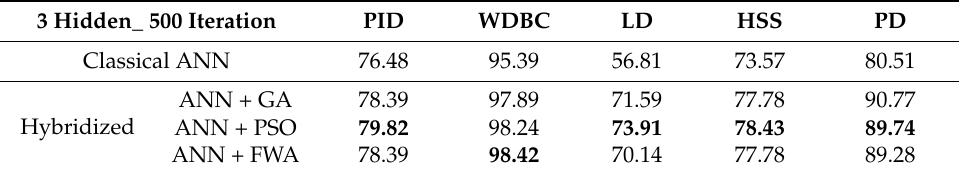
Table 4. 3–hidden-layer ANN hybridized with optimization algorithms GA, PSO, and FWA for 500 iterations.